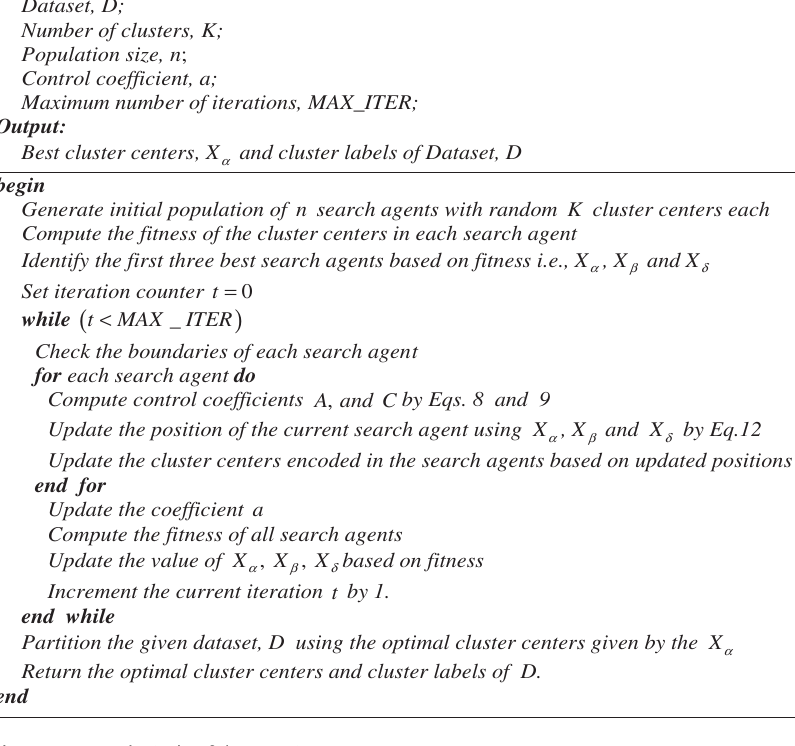
Figure 2: Pseudo Code of the